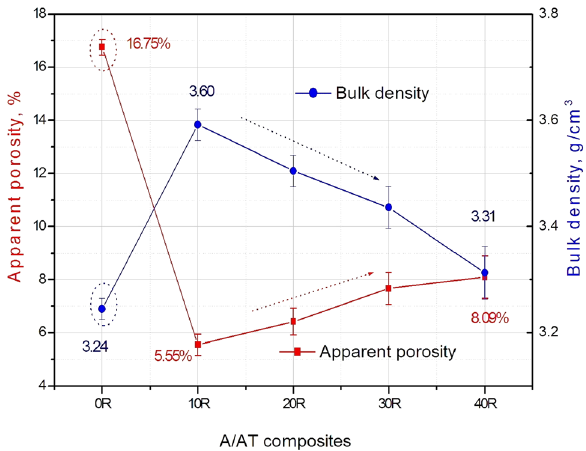
Figure 3. Apparent porosity and bulk density of the sintered A/AT composites with different rutile content (0–40 wt%).